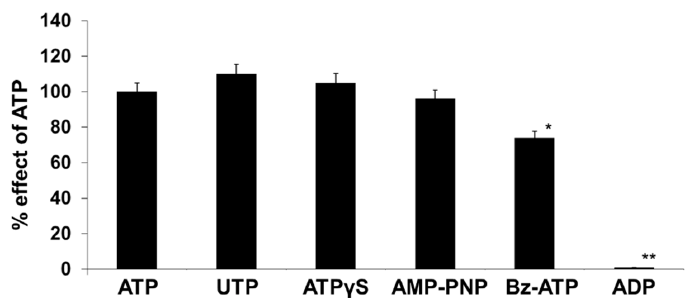
Figure 4. Effects of different nucleotides (100 µ M) on intracellular calcium concentrations in human adipocytes. The effects of the different nucleotides have been normalized to those obtained with ATP. * p < 0.05; ** p < 0.0001.